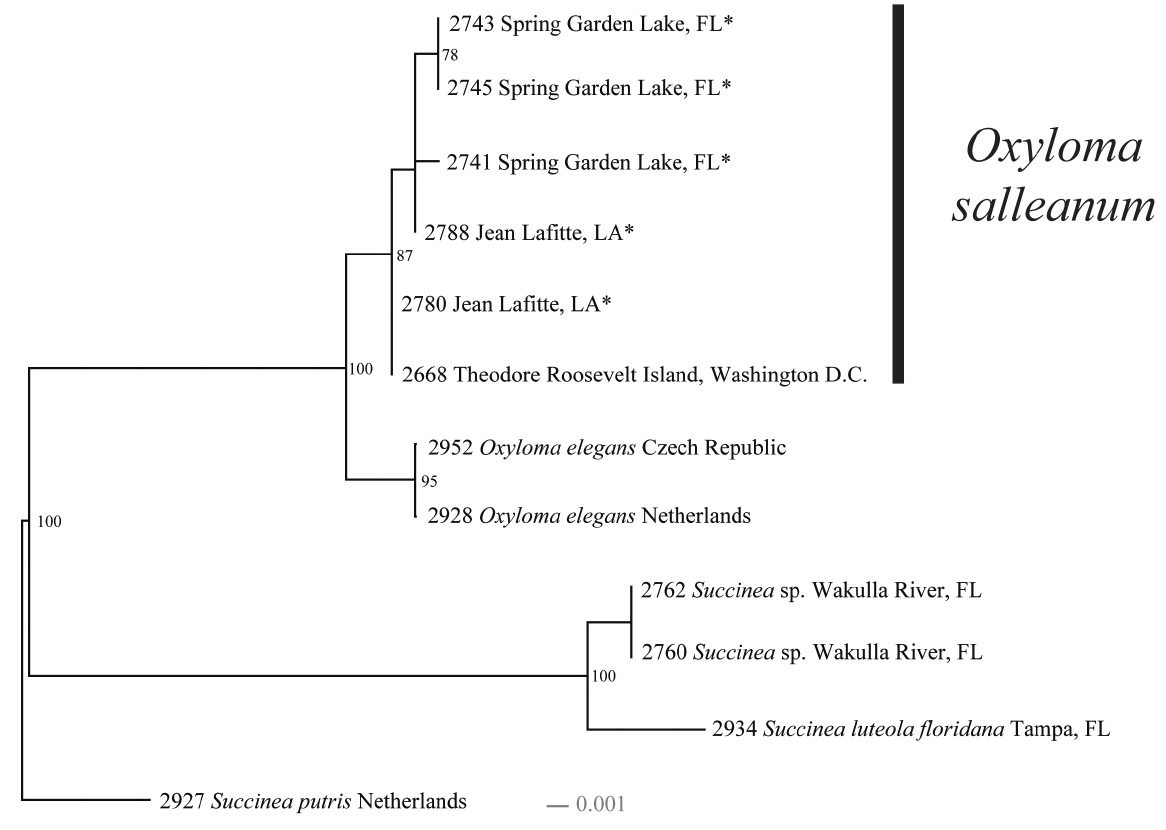
Fig. 3. Maximum likelihood phylogeny from 882 bp alignment of 15 LSU sequences presenting only the focal taxa and localities. Ultra-fast bootstrap values indicated behind the nodes supported. Full 51-individual analysis reported in Supp. file 2, Supp. file 3. Type localities indicated with an